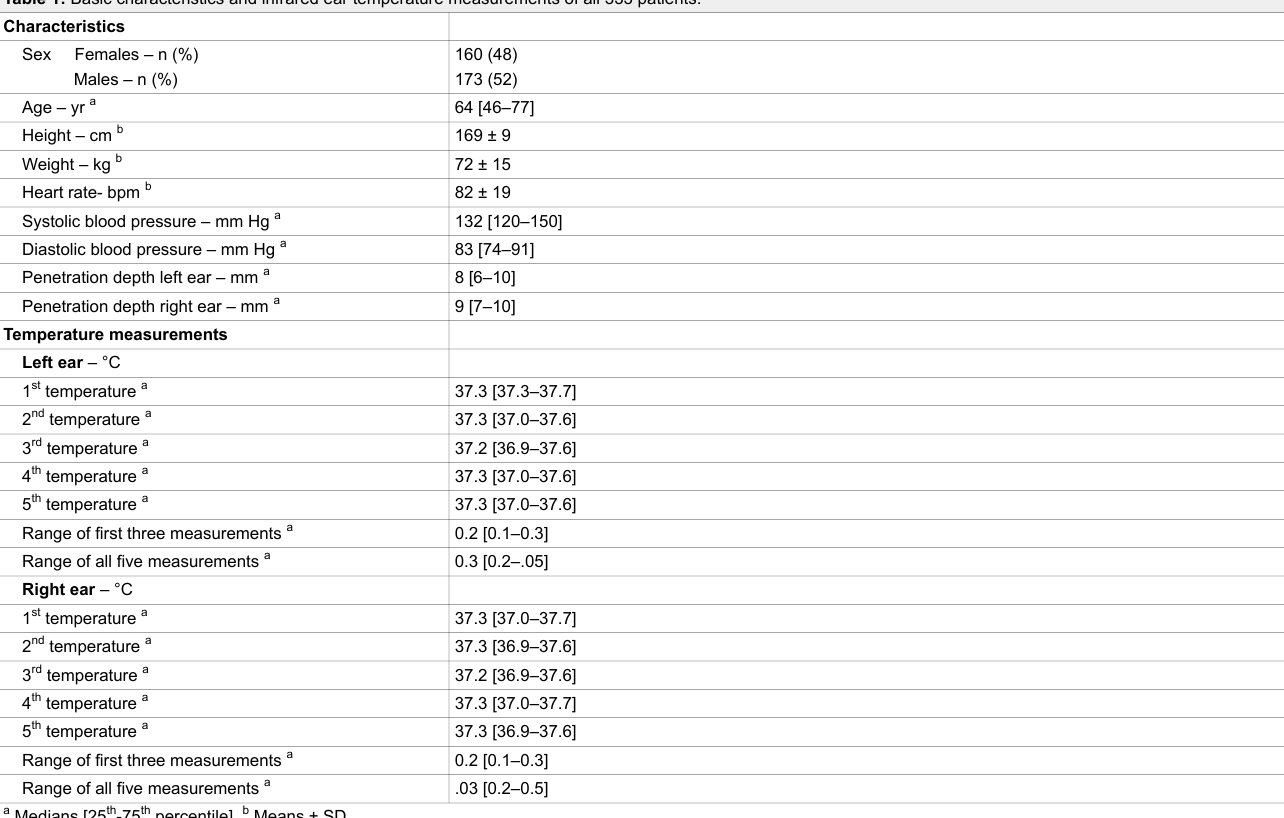
Table 1: Basic characteristics and infrared ear temperature measurements of all 333 patients.